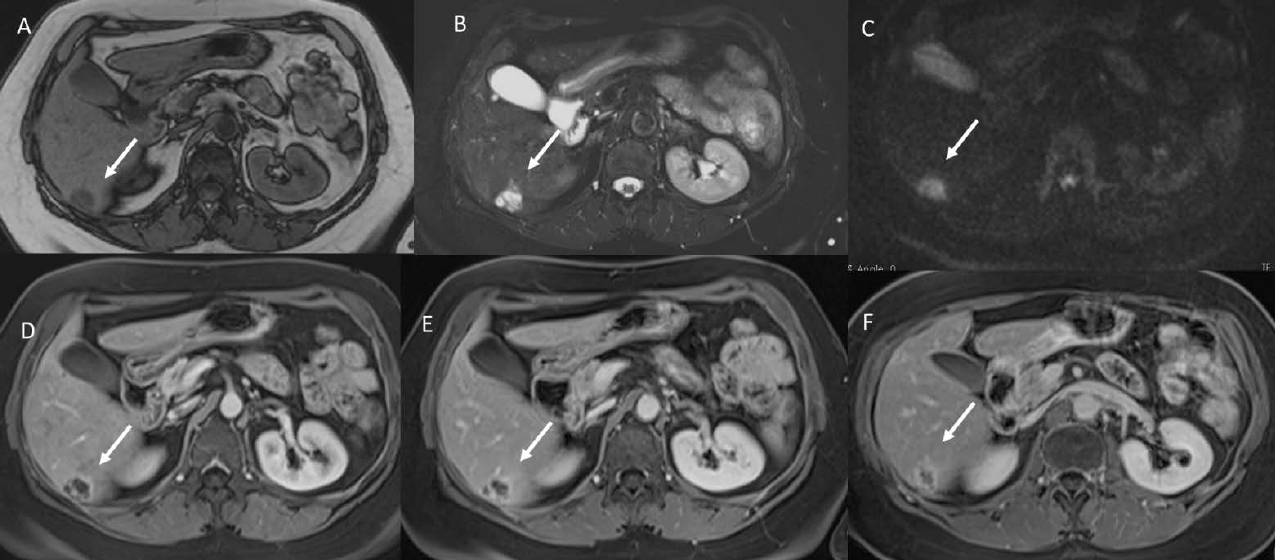
Figure 3. Colorectal mucinous liver metastases, assessed with non-liver-specific contrast agent. The lesion (arrow) shows hypointense signal in T1-W: ( A ) sequence; ( B ) very high hyperintense signal in T2-W; ( C ) restricted diffusion; and targetoid appearance during ( D ) arterial, ( E ) portal, and ( F ) late phase of contrast study.